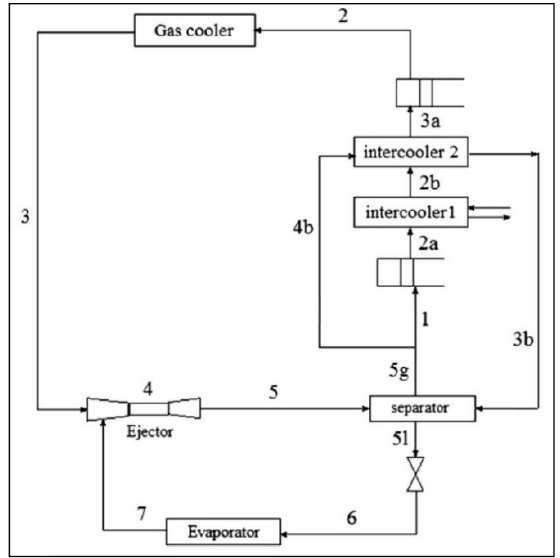
Figure 19. Two-stage multi-inter-cooling transcritical EERC [189].